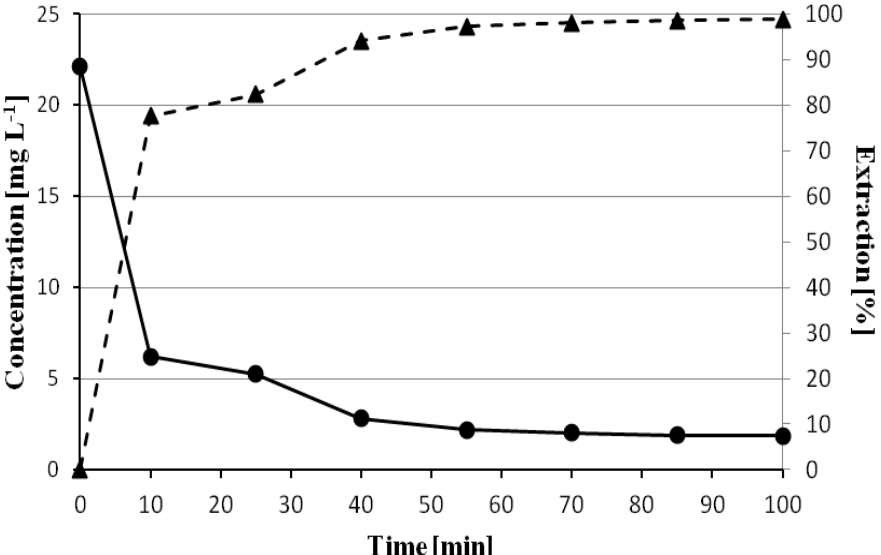
Figure 4. Optimization of the time needed to remove maximum chlorophyll a from solution contain- ing 0.5 mL of spinach leaf extract, 1.5 mL of acetone, and 1 mL of deionized water by the use of 300 mg of polyvinyl chloride (PVC). The circles represent the decrease of the chlorophyll a concentration in time, the triangle signs show the relation between the percentage of its extraction vs. time.